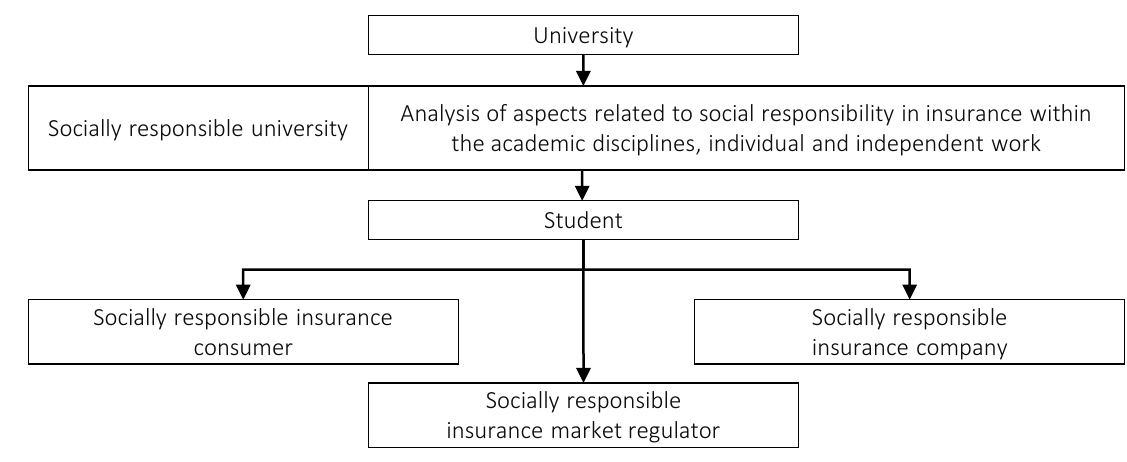
Figure 7. Model of university influence on